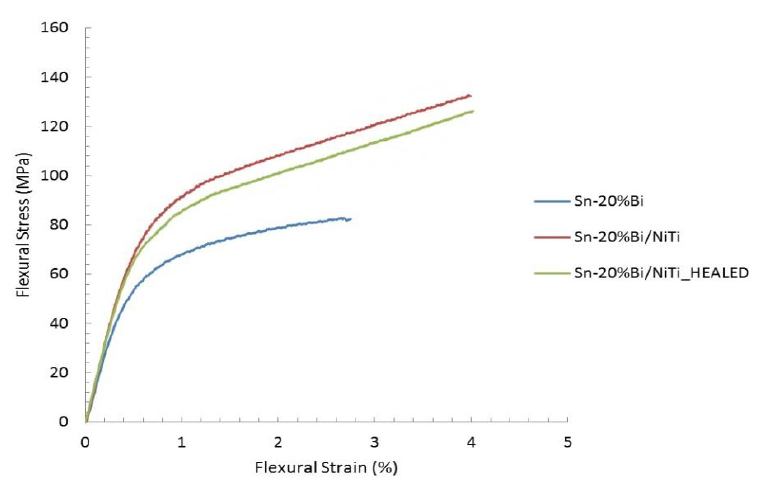
Figure 9. Stress strain relation measured for a pristine sample, healed sample, and a sample composed entirely of matrix material. Reprinted/adapted with permission from Ref. [20]. 2013, Shobhit Misra.